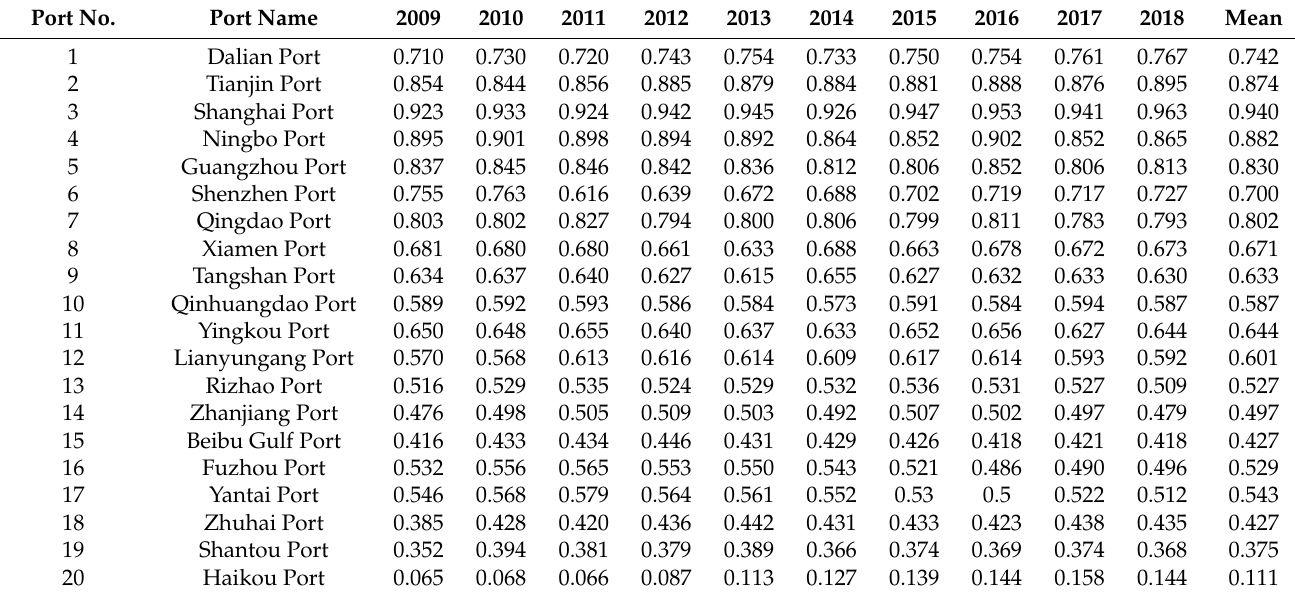
Table 3. Sustainable development capability (SDC) of 20 Chinese ports from 2009 to 2018. Port